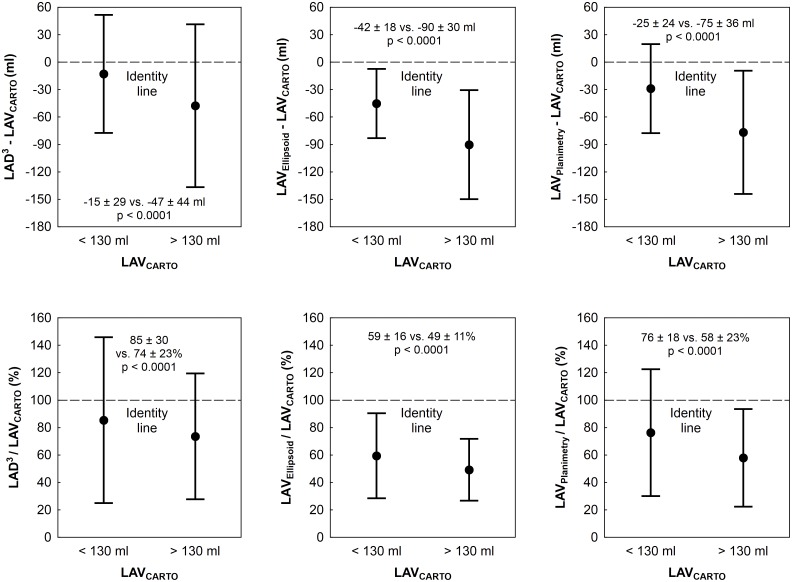
Absolute and relative agreement between 2D-ECHO-based and CARTO-derived LAV in categories by LA size.Absolute and relative differences are shown in upper and lower row of graphs, respectively. Data are dichotomized by median of LAVCARTO (130 ml). The points and whiskers represent mean and ±1.96 standard deviation. Abbreviations as in Fig 1.